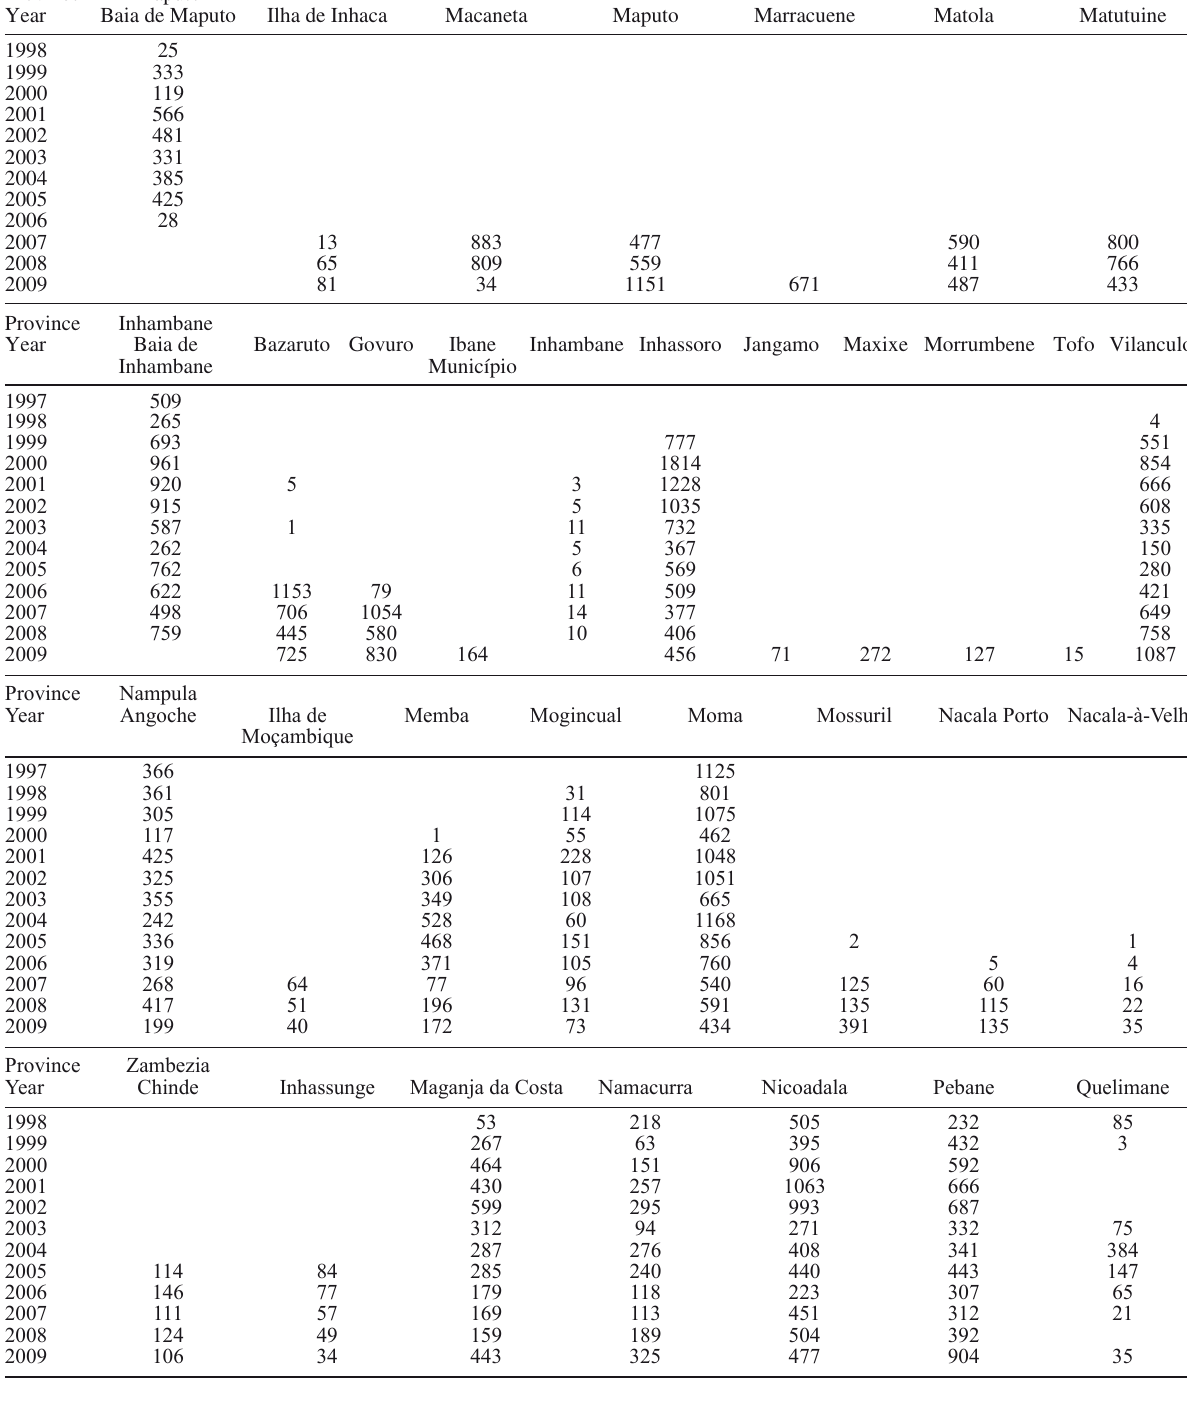
Zambezia and used in the analysis.